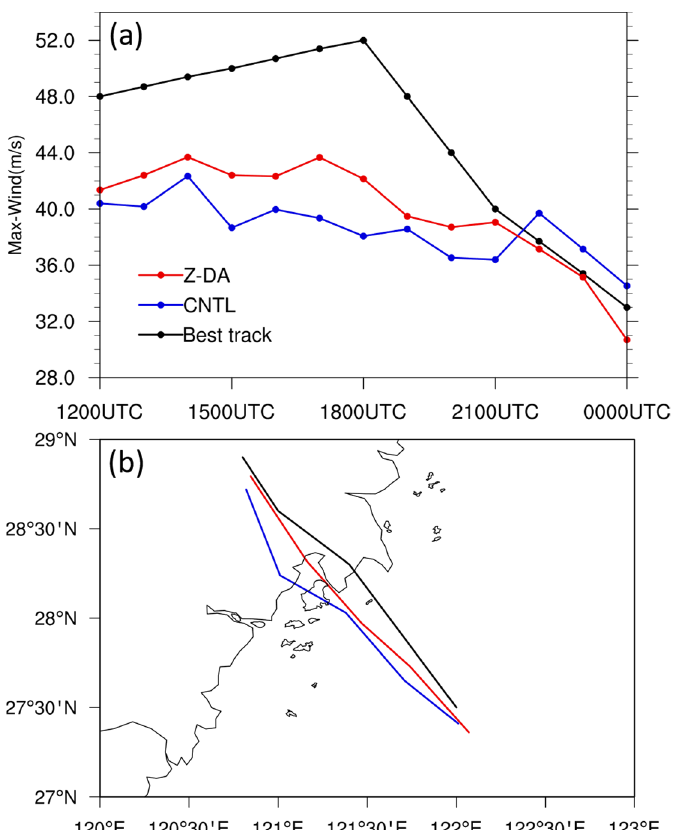
Figure 5. Predicted ( a ) maximal wind speed and ( b ) track for 12 h forecasts from 1200 UTC, 9 August, to 0000 UTC, 10 August 2019, for CNTL (blue lines), and Z-DA (red lines). The best CMA track is shown in black lines.